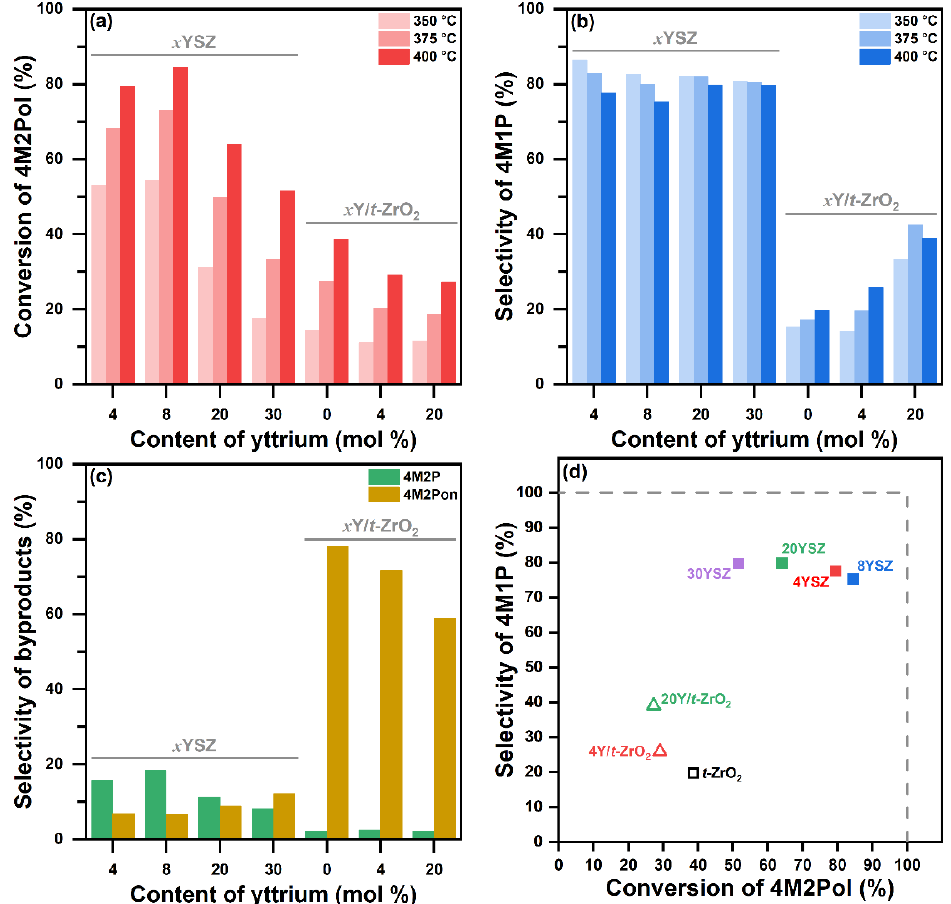
Figure 3. Activity results in dehydration of 4M2Pol over the co-precipitated x YSZ ( x = 4, 8, 20, and 30) and impregnated x Y/ t -ZrO 2 ( x = 4 and 20) catalysts along with bare t -ZrO 2 . ( a ) Conversion of 4M2Pol at 350, 375, and 400 °C. ( b ) Selectivity of 4M1P at 350, 375, and 400 °C. ( c ) Selectivity of by-products such as 4M2P and 4M2Pon at 400 °C. ( d ) Plot to correlate 4M2Pol conversion with 4M1P selectivity obtained at 400 °C.